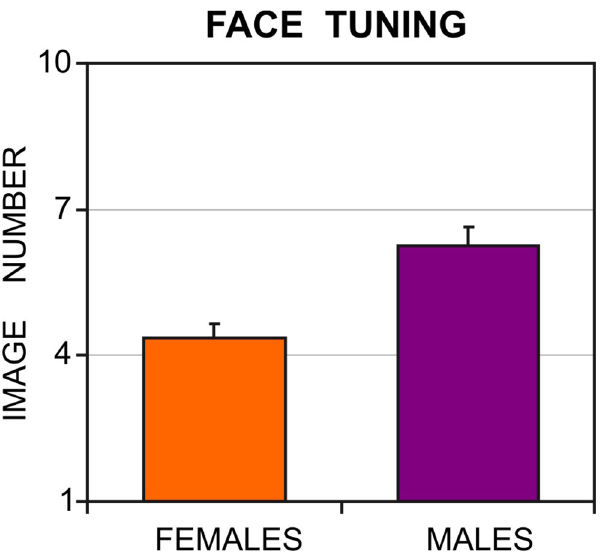
Fig 3. Gender difference in tuning to faces. In the Face-n-Food task, females more readily recognize images as a face than males. Vertical bars represent SEM. doi:10.1371/journal.pone.0130363.g003 Fig 4 represents the proportion of face responses for each Face-n-Food image for females and males. As seen from this figure, females not only earlier report seeing a face, give more face responses, but also faster than males reach a ceiling level of performance giving the maximal number of face responses. This is confirmed by statistical analysis performed on individual